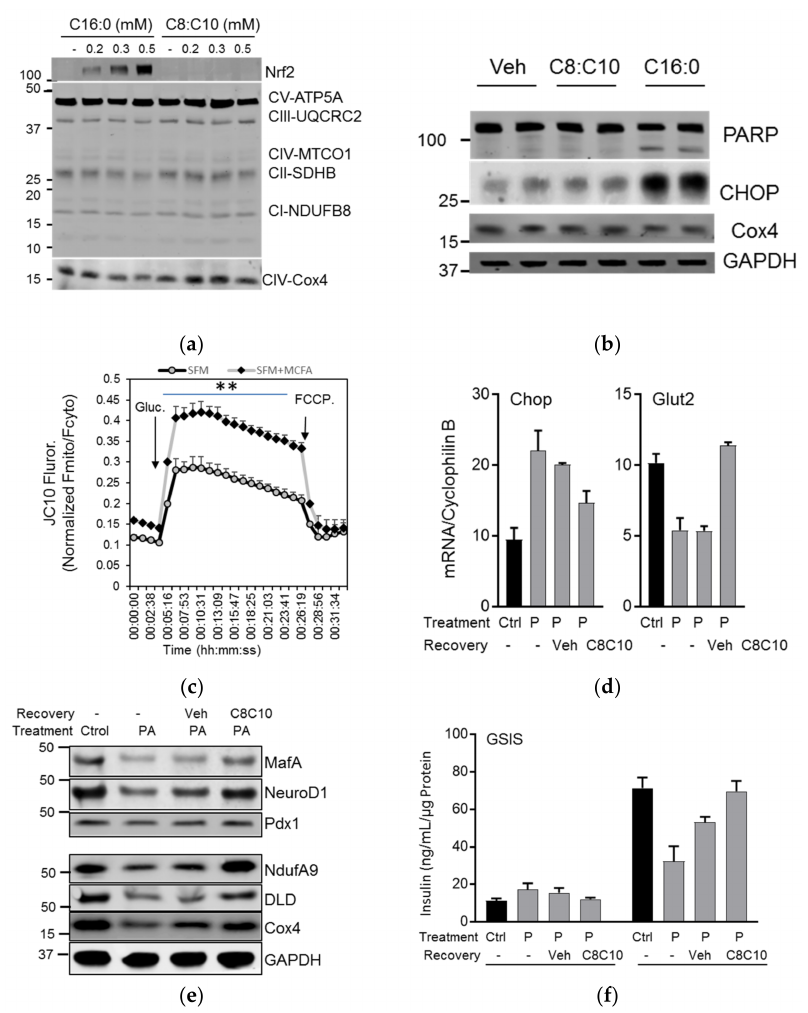
Figure 5. MCFA helps the β -cells recover from chronic palmitate induced dysfunction. ( a ) Representative immunoblotting of INS1E cells after chronic treatment with increased concentrations of palmitate or MCFA C8:C10 mixture with antibodies against Nrf2 and mitochondrial respiratory chain proteins. ( b ) Assessment of apoptotic and ER stress signaling after chronic treatment with palmitate (C16:0) or MCFA C8:C10 mixture after immunoblotting with antibodies against PARP (Poly(ADP-Ribose) Polymerase), CHOP, Cox4 (Cytochrome C Oxidase Subunit 4) and GAPDH (Glyceraldehyde-3-Phosphate Dehydrogenase) as loading controls. ( c ) Mitochondrial membrane potential (MMP) in response to 16.7 mM glucose in INS-1E cells chronically treated with vehicle control (Ctrl) or the MCFA C8:C10 mixture, using the fluorescent lipophilic cation IP10. Changes in MMP are expressed as the ratio of the fluorescence in mitochondria divided by the cytosolic fluorescence (Fmito/Fcyto) measured in the same cells. At the end of the recording, the protonophore, FCCP (2 µ M) was used to dissipate MMP. Data shown are the means ± SEM from three independent experiments done in sextuplet in 96-welled plates, ** p < 0.01. ( d ) Expression of CHOP and Glut2 by qPCR in INS1E cells after chronic treatment with palmitate and recovery in control medium or MCFA-enriched medium. ( e ) Western blot analysis of transcription factors regulating β -cell function (MafA, NeuroD1, PDX1) or mitochondrial proteins (NDUFA9, DLD, Cox4) after treatment as above; GAPDH was used as a loading control. ( f ) Analysis of β -cell function after impairment with chronic palmitate and recovery as above by insulin secretion under basal (2 mM glucose) and stimulated (16.7 mM glucose + 0.1 µ M Ex-4) conditions. Data represent means + SEM of three independent experiments; * p < 0.05, ** p < 0.01 relative to control cells and # p < 0.05 relative to palmitate control